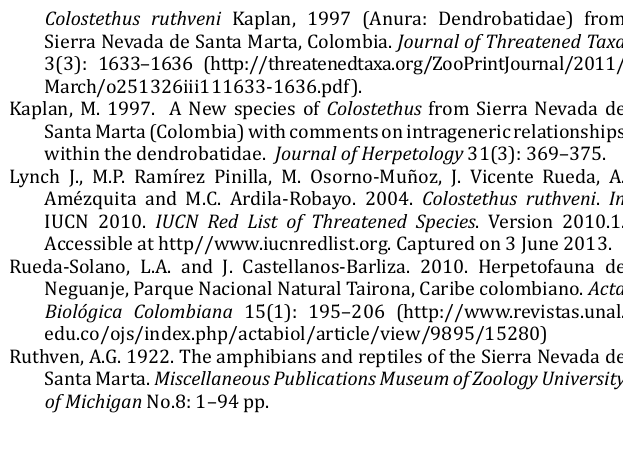
Figure 2. Study area. Current known distribution and recent records